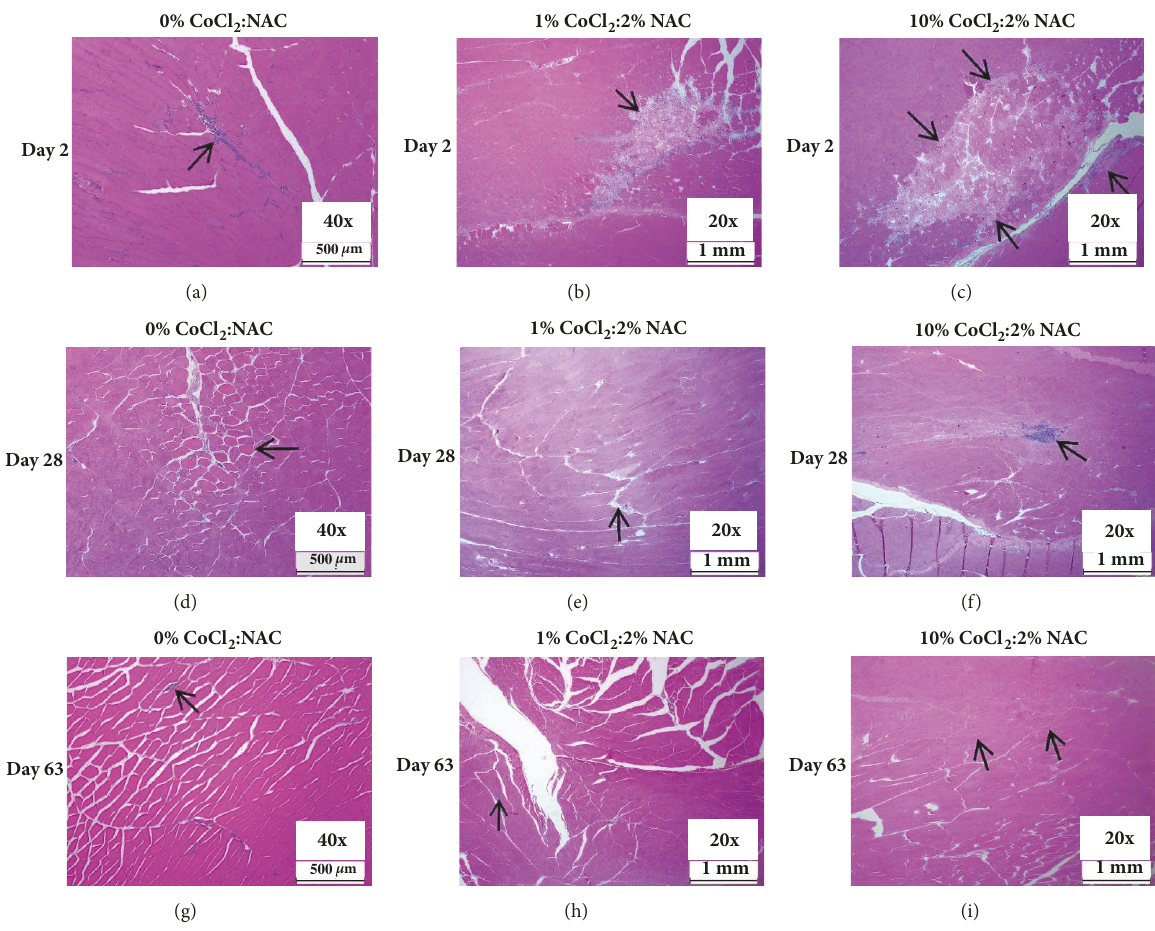
Figure 1: Histopathological changes of skeletal muscle at the site of C4 (CoCl 2 :NAC) injection. A volume of nine microliters of CoCl 2 :NAC at various concentrations (0% CoCl2:NAC [control], 1% CoCl2:2% NAC [mid- or reference dose], and 10% CoCl2:2% NAC [high dose]) was injected intramuscular into the middle region of the left hind limb quadriceps femoris muscle of male Sprague-Dawley rats. Images of H&E stained tissue sections at 20x and 40x magnification. (a)–(c) Images show mild inflammation (arrow) in control animals (a) and acute degeneration and necrosis of myofibers with granulomatous inflammation at the site of intramuscular injection (arrows) in the mid- and high-dose groups ((b) and (c), respectively), at 48 hours after treatment. (d)–(f) Images show minimal edema with occasional degenerated myofibers (arrow) in control (d) and middose group (e) animals, which is associated with focal mild lymphohistiocytic inflammation (arrow) and myofiber regenerationin the high-dose group (f), at 28 days after treatment.(g)–(i) Images reveal presenceof rare small foci of histiocytic inflammation (arrow) similar in control and treated groups of animals ((g), (h), and (i)), and areas of normally regenerated myofibers surrounded by minimal interstitial fibrosis in the mid- and high-dose groups ((h) and (i), respectively), at 63 days after